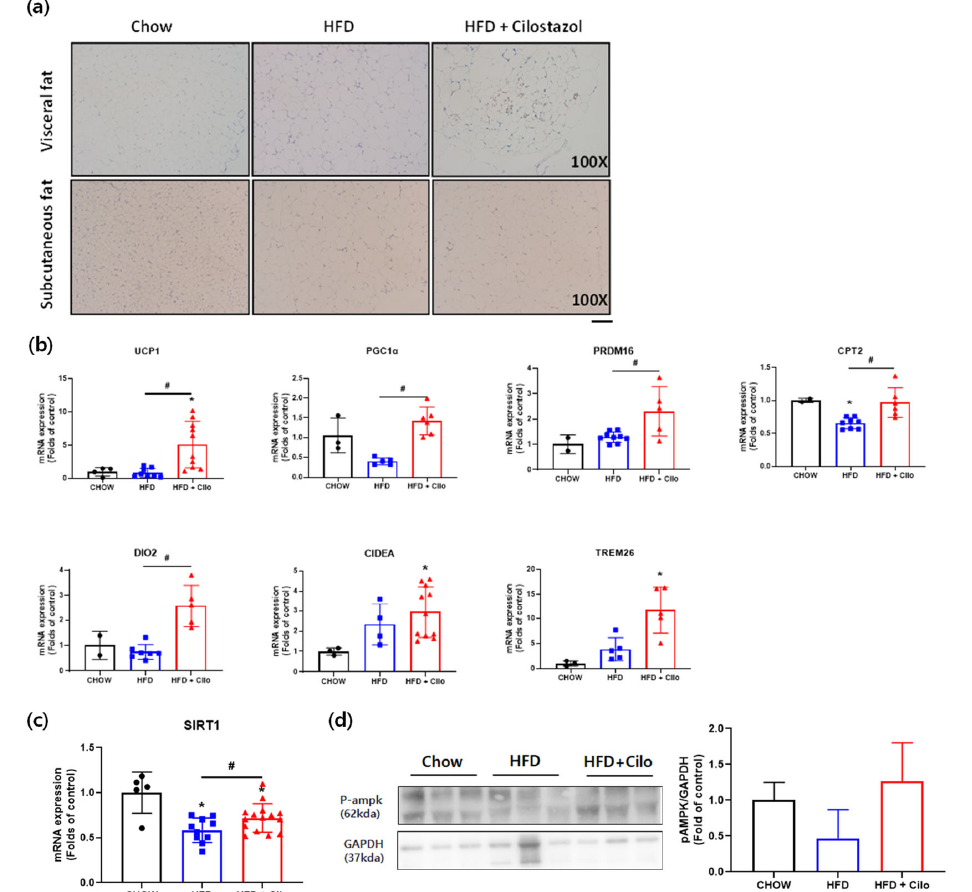
Figure 3. Cilostazol treatment-induced white-to-beige phenotypic conversion of WAT in HFD mice. ( a ) Representative histological images of UCP1 immunohistochemical-stained (brown) visceral and subcutaneous WAT ( × 100 magnification) of chow control, HFD control, and cilostazol-treated HFD mice; ( b ) RT-PCR analysis of browning genes in visceral WAT; ( c ) relative mRNA expression levels of thermogenesis-related genes and sirtuin 1 (SIRT1) in visceral fat; and ( d ) protein levels of phosphorylated AMP-activated protein kinase (pAMPK) in visceral fat were determined using Western blot analysis. The graph on the right shows the densitometric analysis of the pAMPK/glyceraldehyde 3-phosphate dehydrogenase (GAPDH) ratio determined from the immunoblots shown on the left. * p < 0.05 vs. corresponding chow control value and # p < 0.05 vs. corresponding HFD control value. HFD, high-fat diet; Cilo,